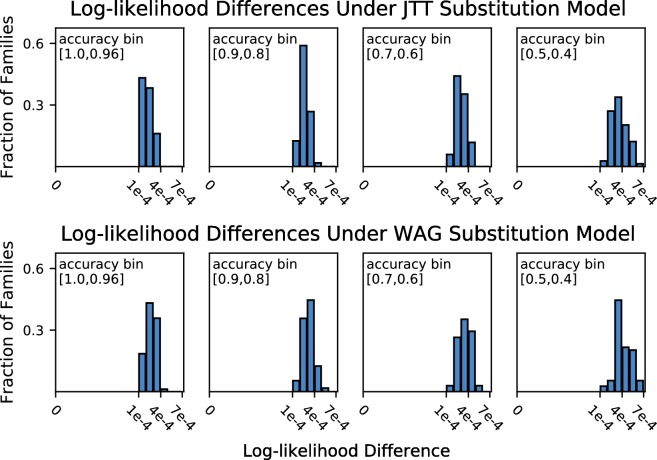
Histograms of log-likelihood differences between true and all-sequence (reference) topologies, calculated over all-sequence alignments under the JTT (top panel) and WAG (bottom panel) substitution models.10.7554/eLife.47676.008Figure 2—figure supplement 1—source data 1.Log-likelihood differences between true and all-sequence topologies.